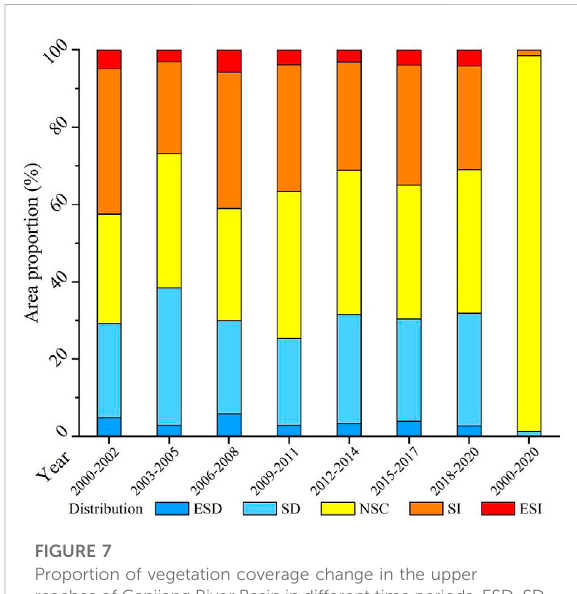
FIGURE 7 Proportion of vegetation coverage change in the upper reaches of Ganjiang River Basin in different time periods. ESD, SD, NSC, SI, and ESI denote extremely signi fi cant decrease, signi fi cant decrease, non-signi fi cant change, signi fi cant increase, and extremely signi fi cant increase, respectively.